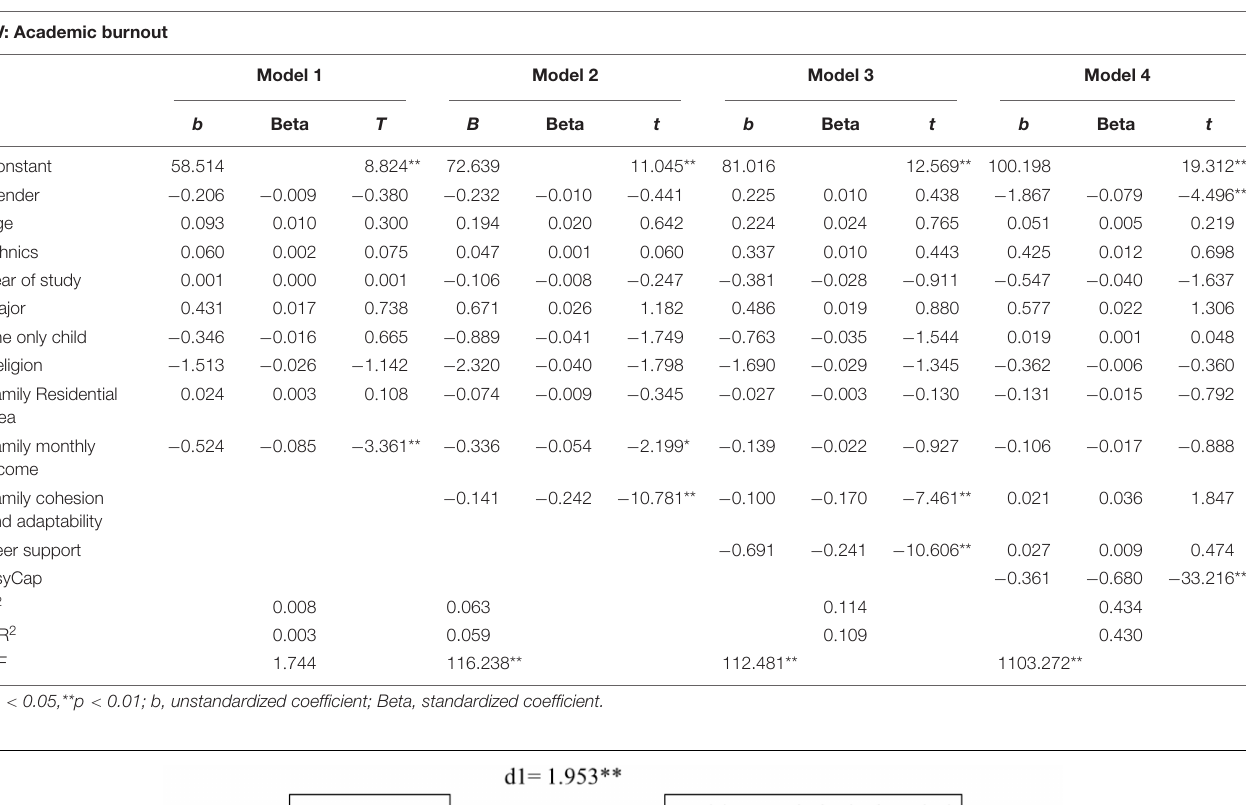
TABLE 3 | Hierarchical regression analyses of academic burnout.